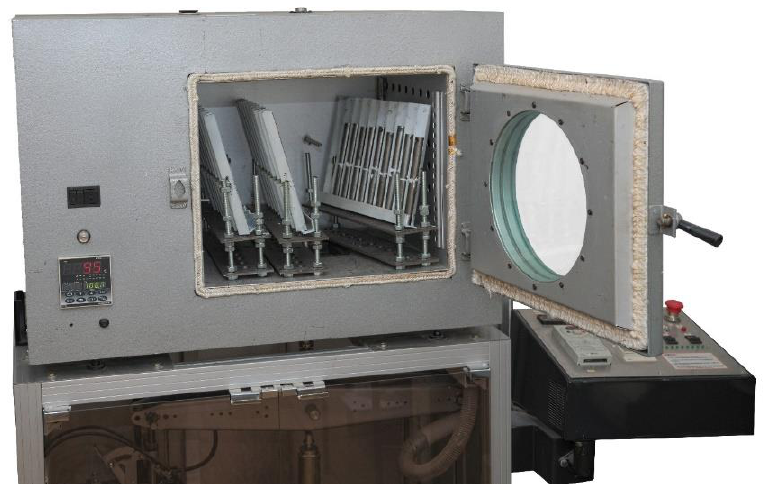
Figure 2. Positioning brackets for the correct orientation of the bonded specimens in the heating chamber.